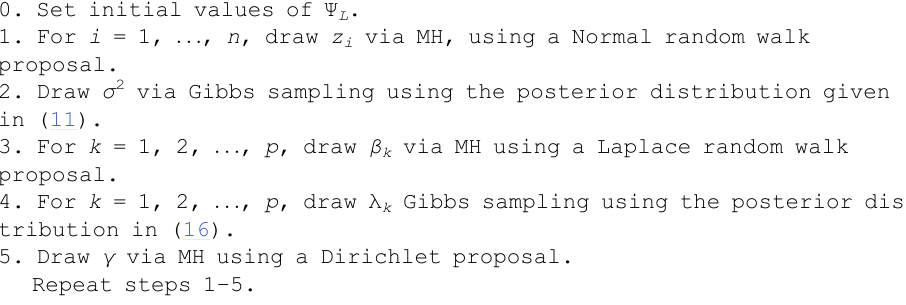
Algorithm 2: MCMC algorithm for LASSO-based